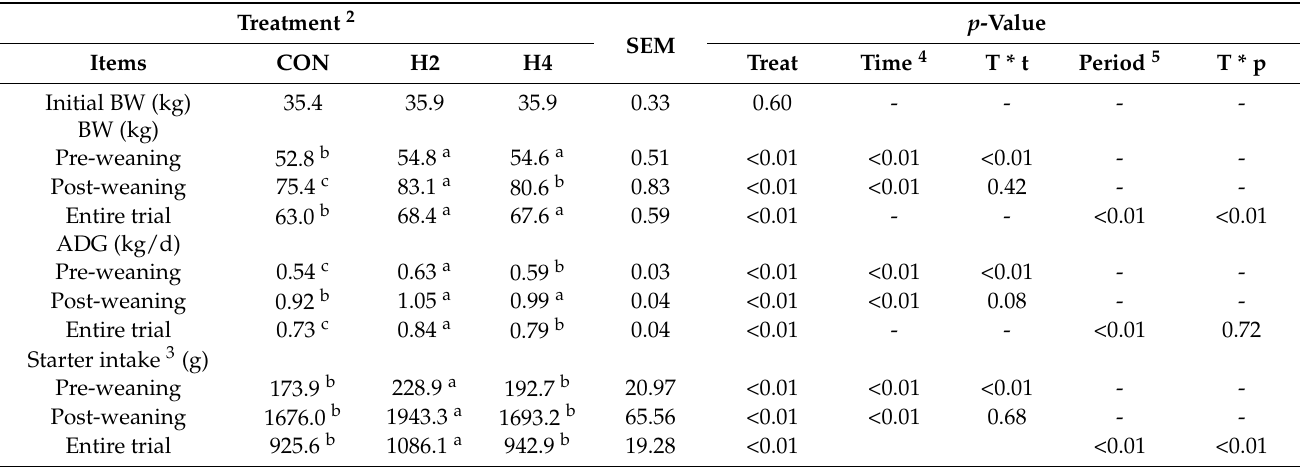
Table 3. Effects of hay supplementation from either week two or four on BW (body weight), ADG (average daily gain) and starter intake in dairy calves during different periods 1 (CON: n = 70; H2: n = 70; H4: n = 70).